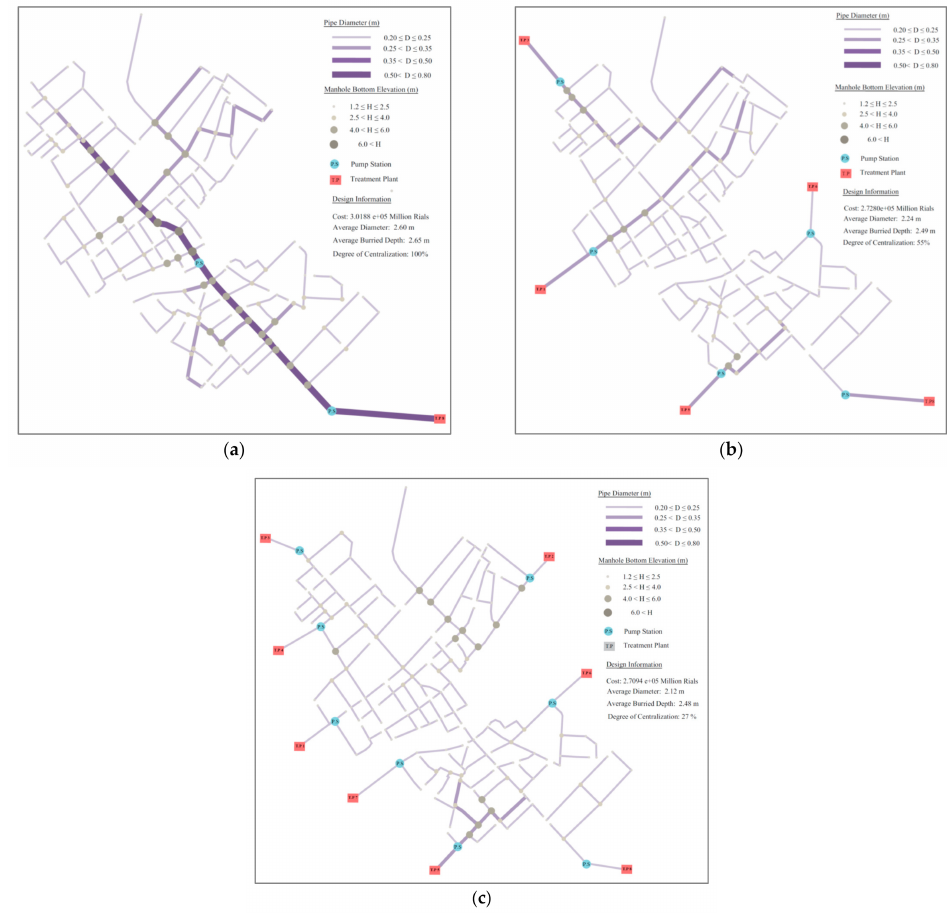
Figure 11. Various design scenarios: ( a ) scenario 1, optimal fully centralized design (DC = 100%); ( b ) scenario 2, design with 5 treatment plants (DC = 55%); ( c ) scenario 3, the most decentralized design (DC =